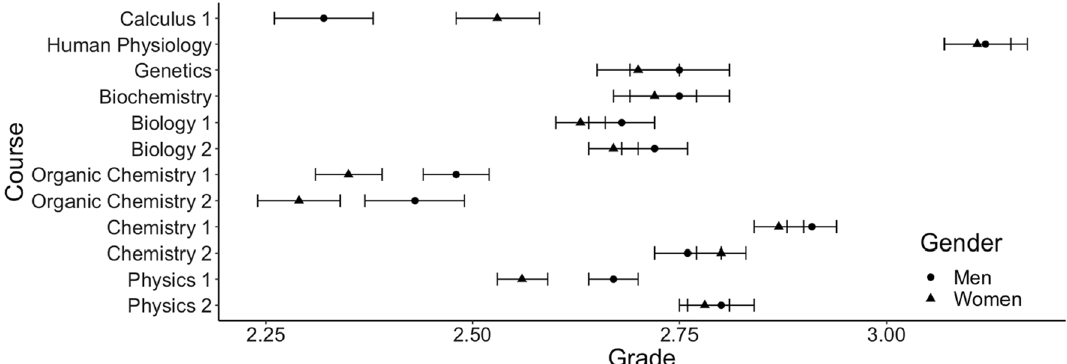
Fig. 3 Average grade anomalies (AGAs) for each course of interest, by gender. The error bars represent standard